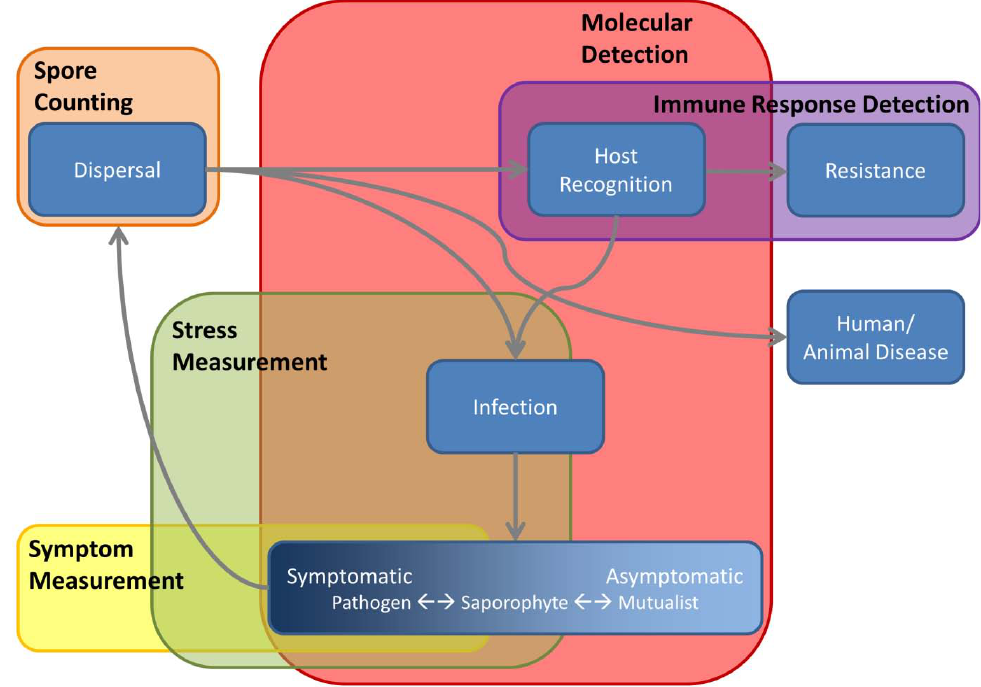
Figure 1. Summary of major steps and outcomes associated with microbial infection of crops. Major steps in the host/microbe interaction are represented by blue boxes, with routes between these steps indicated by arrows. The phenotypic state of the infection is in the blue gradient box. Methodologies that allow investigation of these main stages are